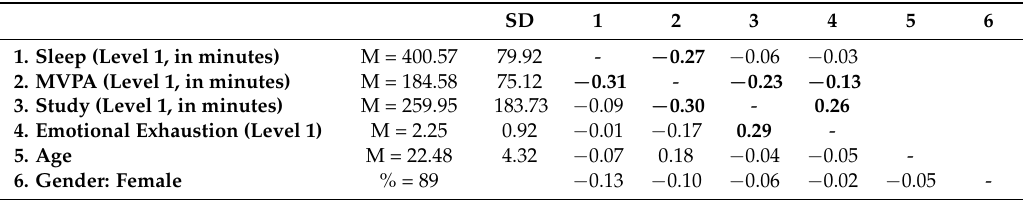
Table 1. Means, standard deviations, and correlations between study